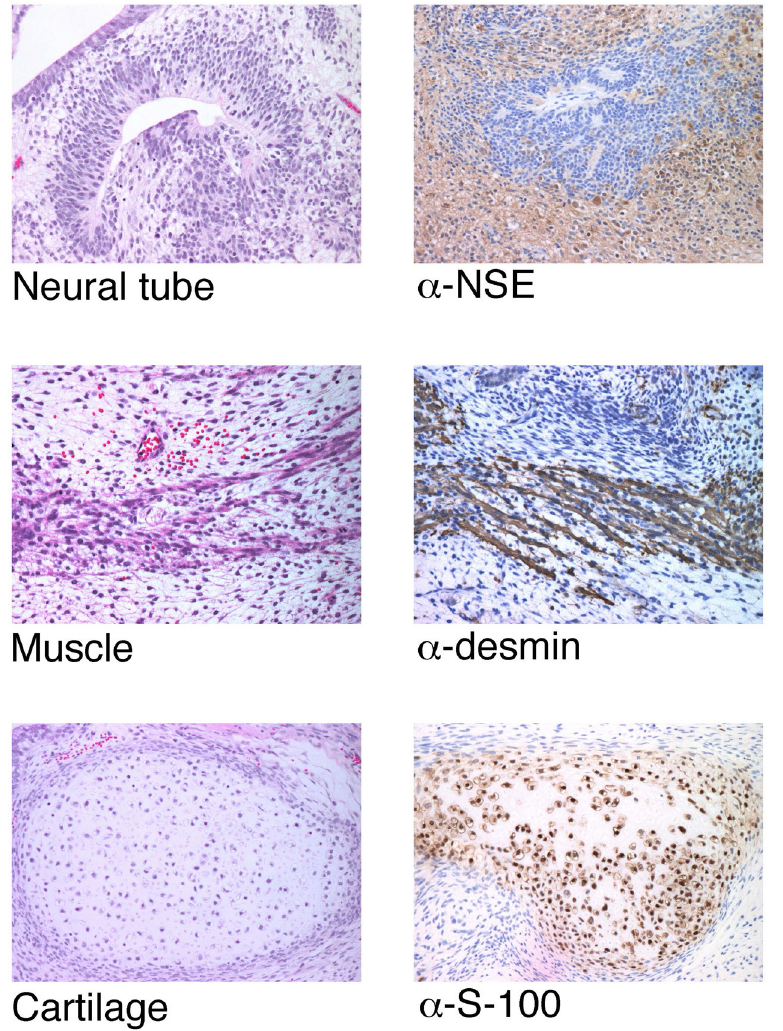
FIGURE 4 . Differentiation of the neural tube, muscle, and cartilage in teratomas formed by hypodermal injection of cynomolgus monkey ES cells into a SCID mouse and expression of tissue specific markers. Immunohistochemistry indicated differentiation of neurons and glia expressing neuron specific enolase, muscle expressing desmin and cartilage expressing